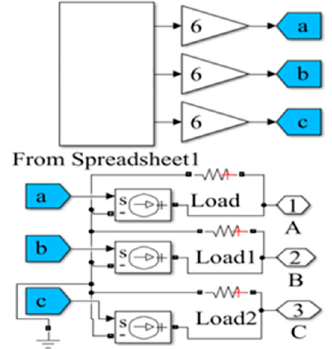
Figure 10. Generator module of AC sides on MATLAB.